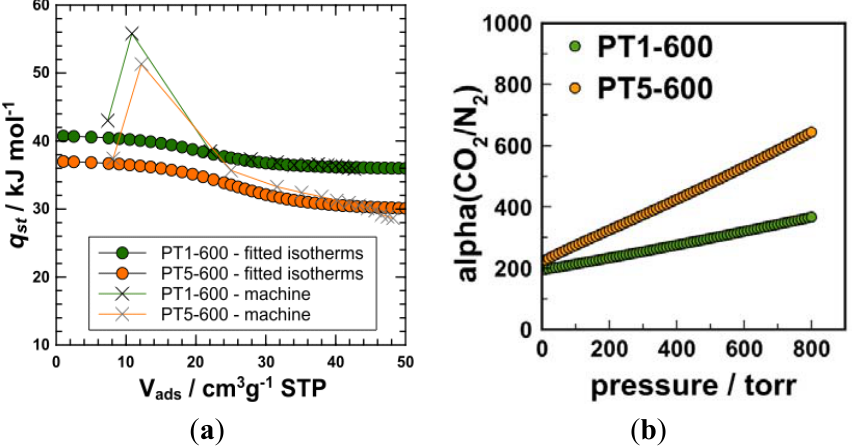
Figure 5. Isosteric heat of carbon dioxide adsorption of ( a ) PT1-600 and PT5-600; and ( b ) IAST prediction of the gas selectivity of PT1-600 and PT5-600 for the gas pair CO 0.15/0.85 composition at 273